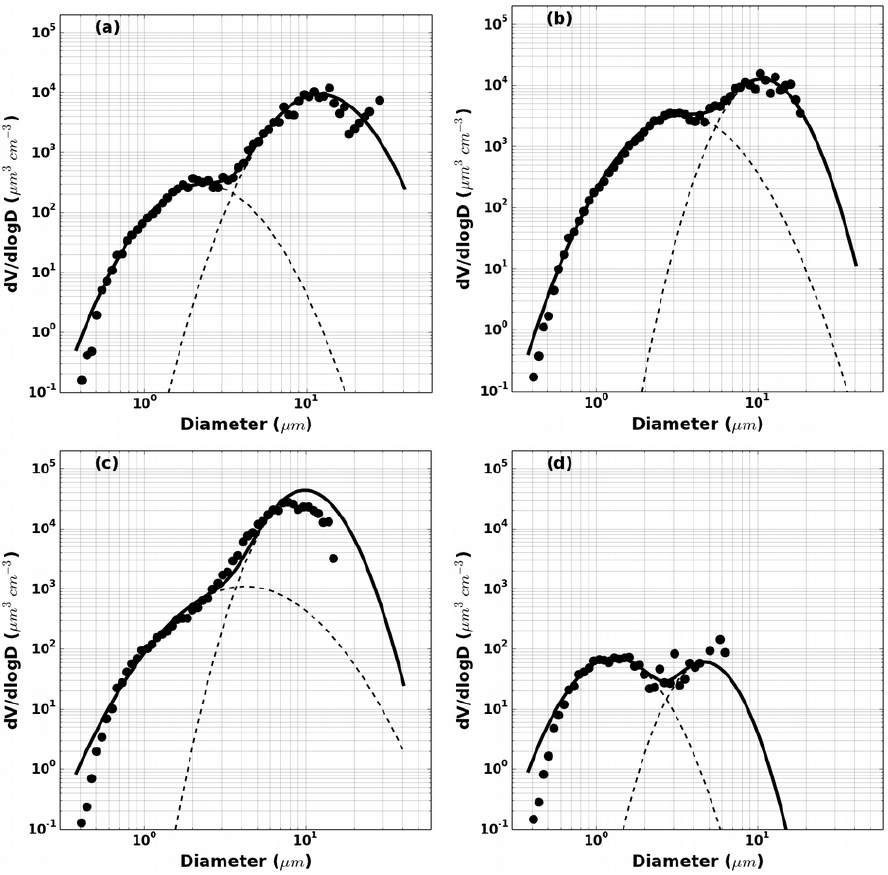
Figure 2. Particle volume size distributions measured by WELAS and averaged at 15min, during four fogs of November 2011. Measurements are shown by dots, and approximations by log-normal distributions are shown by the lines, dashed lines for the monomodal distributions, and a thick continuous line for the bimodal distribution. (a) 2 November, 02:00UT, during fog f1; (b) 10 November, 20:00, during fog f2; (c) 26 November, 06:00, during fog 16; (d) 28 November, 07:30, during fog